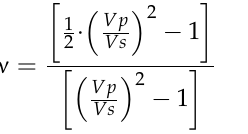
Table 5 shows the mechanical properties used in both numerical models. Table 5. Dynamic parameters used in both 2D numerical models for sections AA’, BB’: values in brackets are the values used in Section AA’.